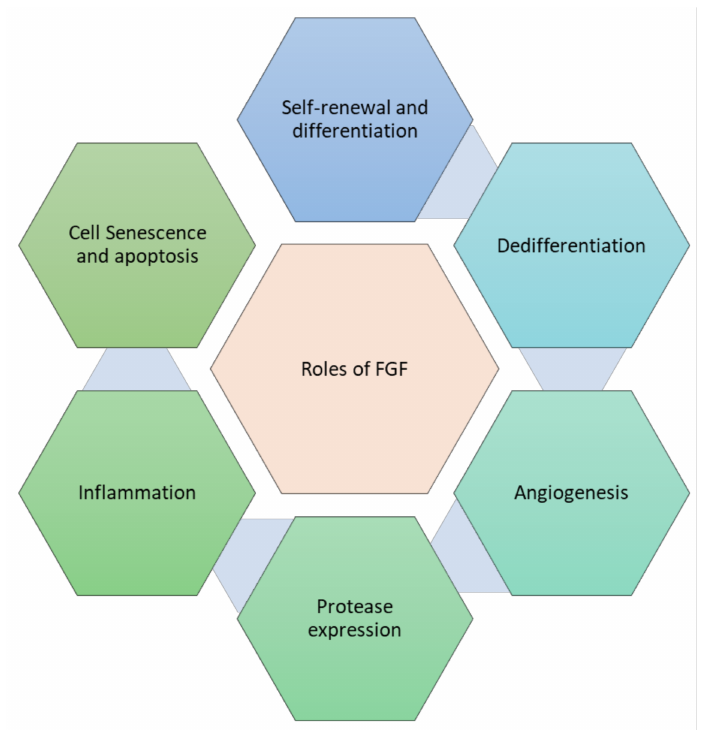
Figure 4. Role of FGF in tissue repair